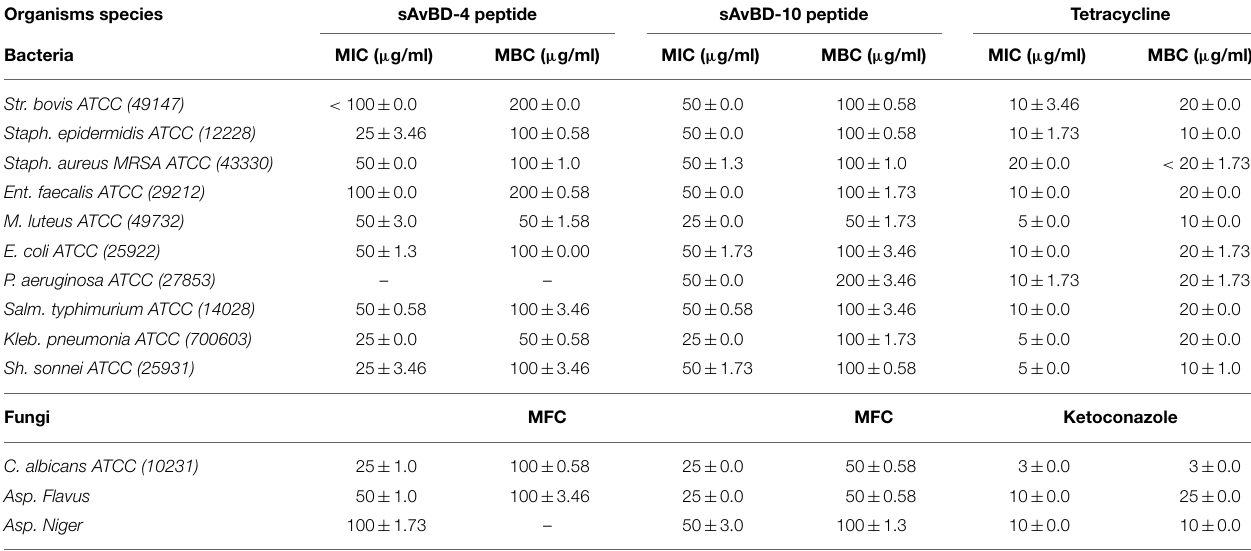
TABLE 2 | The antimicrobial activities of synthetic chicken β -defensin-4 and 10-derived peptide. Organisms